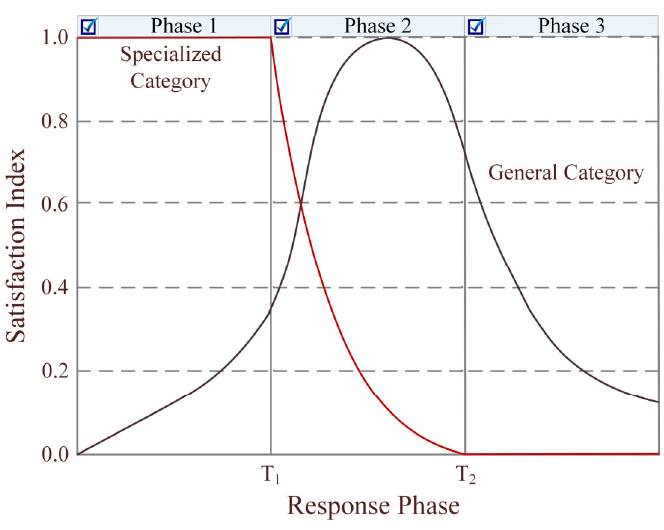
Figure 3. Phased resource benefits.